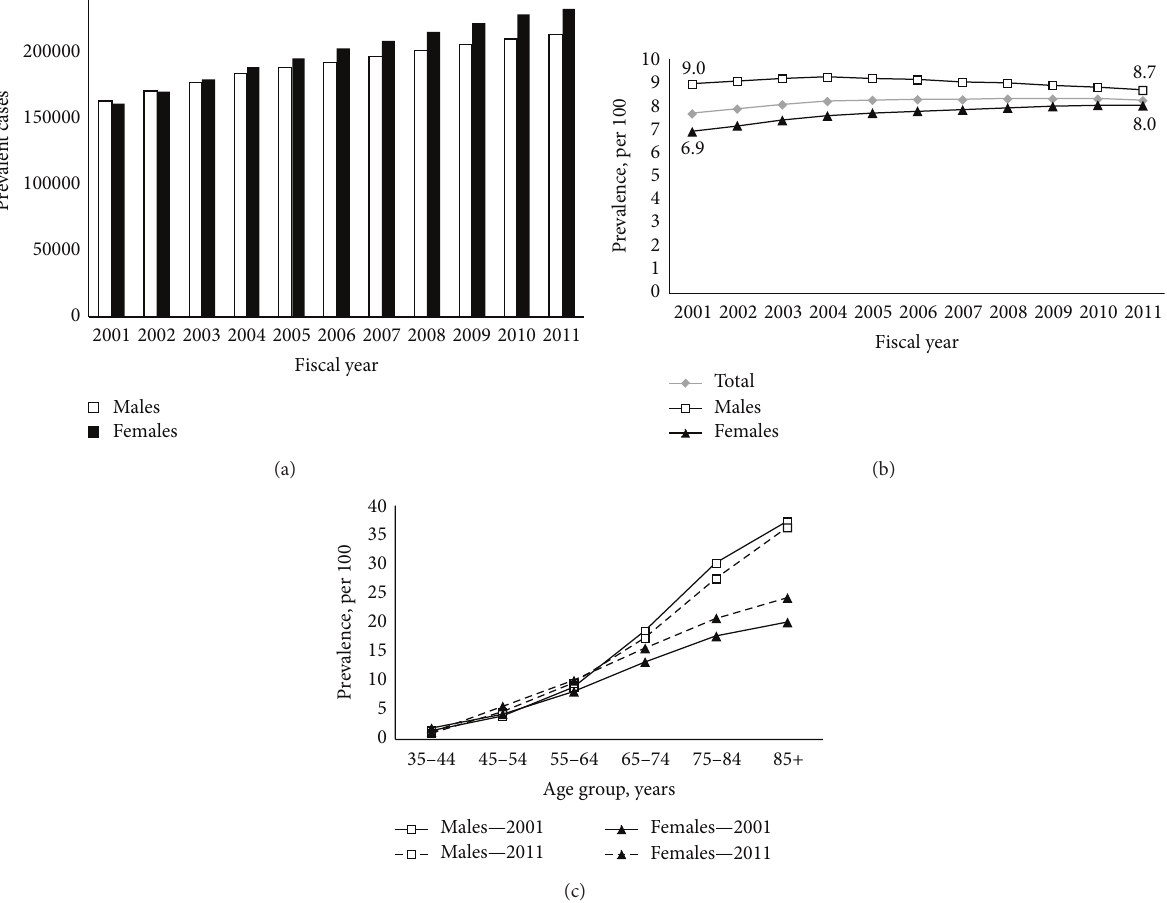
Figure 2: COPD prevalence. (a) Number of prevalent diagnosed COPD cases, 35 years and older, by sex, Quebec, 2001–2011. (b) Age- standardized COPD prevalence, 35 years and older, by sex, Quebec, 2001–2011. (c) Age-specific COPD prevalence, by sex, Quebec, 2001 compared to 2011